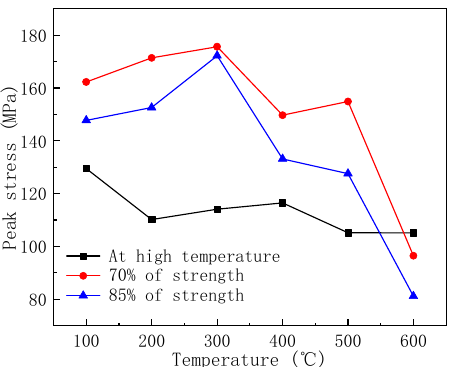
Figure 5. Comparison of UCS of samples at high temperature and after exposure to 10 cycles of temperature and stress.